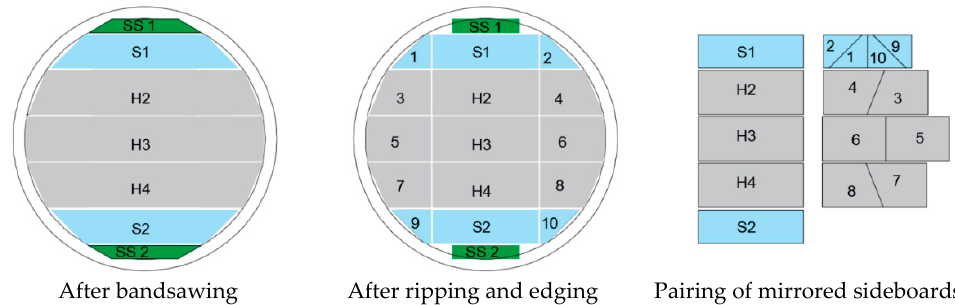
Figure 2. Valorization of tapered sideboards by edge-cutting at 45° and gluing.